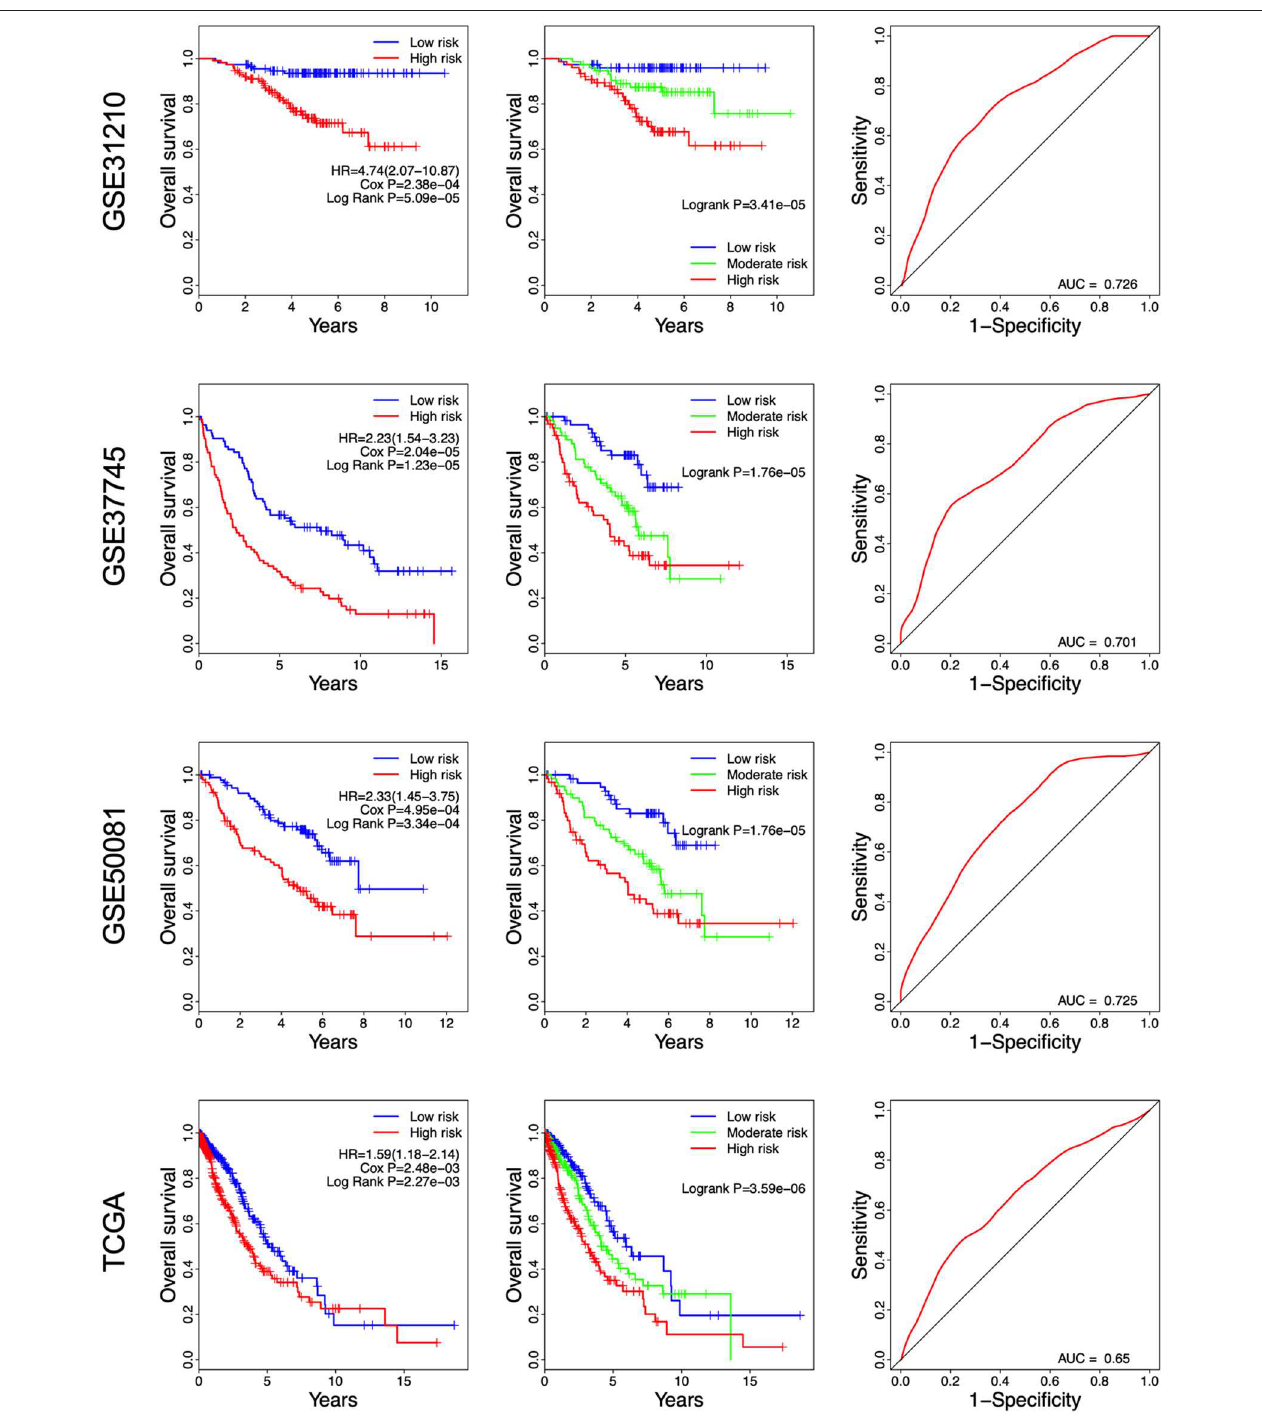
FIGURE 3 | Kaplan-Meier and ROC curves for the 8-gene signature in the four datasets. Patients with high risk scores had poor outcome in terms of overall survival.